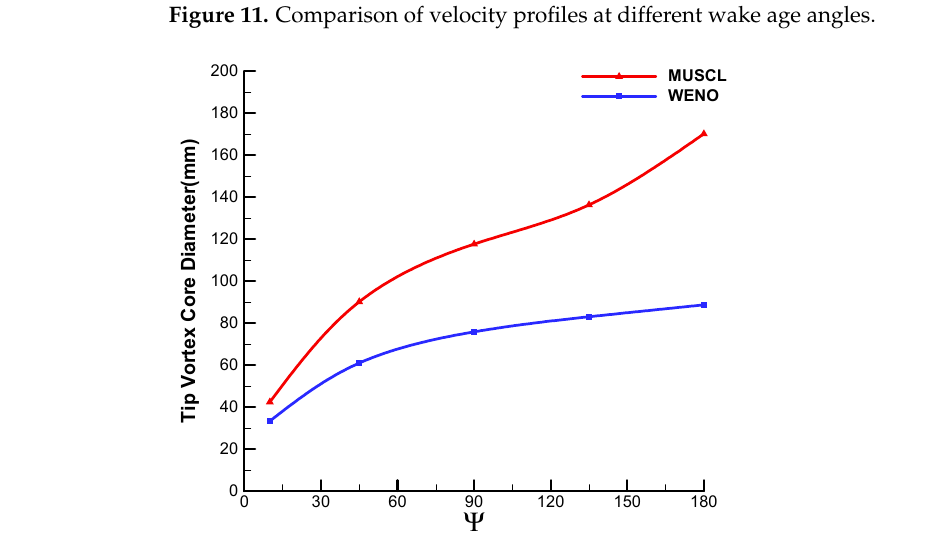
Figure 12. Comparison of vortex core diameters at different wake age angles. Figure 13 compares the position of the vortex core during a full rotor rotation in the ra- dial and axial directions respectively. The radial positions of the vortex core mainly reflects the contraction of tip vortices during evolution. The contraction ratio of tip vortices is large before Ψ = 200 deg and declines gradually after Ψ = 200 deg, the vortex radial positions are nearly maintained. The calculated values are smaller than the experimental